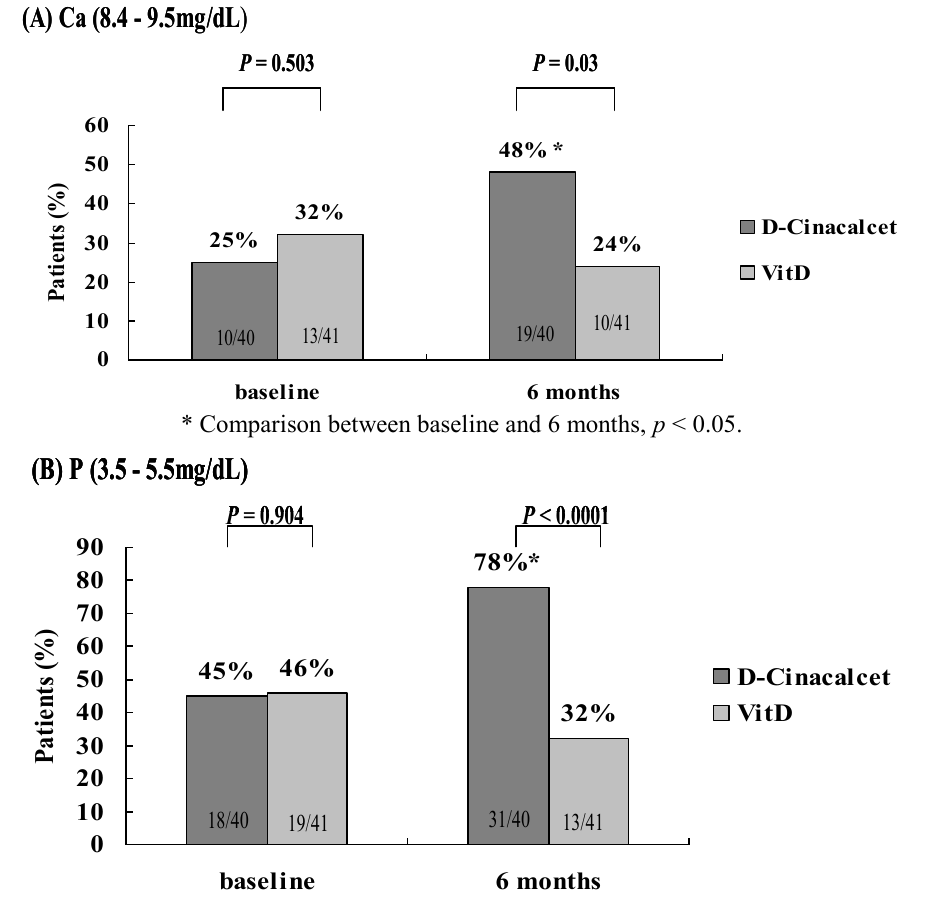
Figure 1. Percentages of patients who achieved the biochemical targets including ( A ) Ca: 8.4–9.5 mg/dL; ( B ) P: 3.5–5.5 mg/dL; and ( C ) Ca × P < 55 mg 2 /dL 2 , recommended by